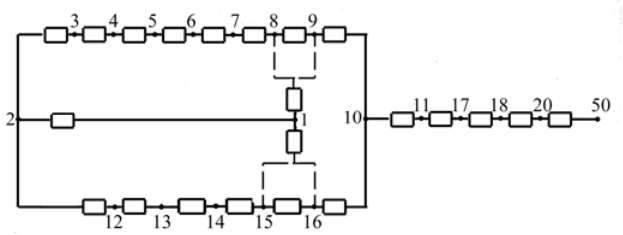
Fig 6. The equivalent hydraulic scheme of